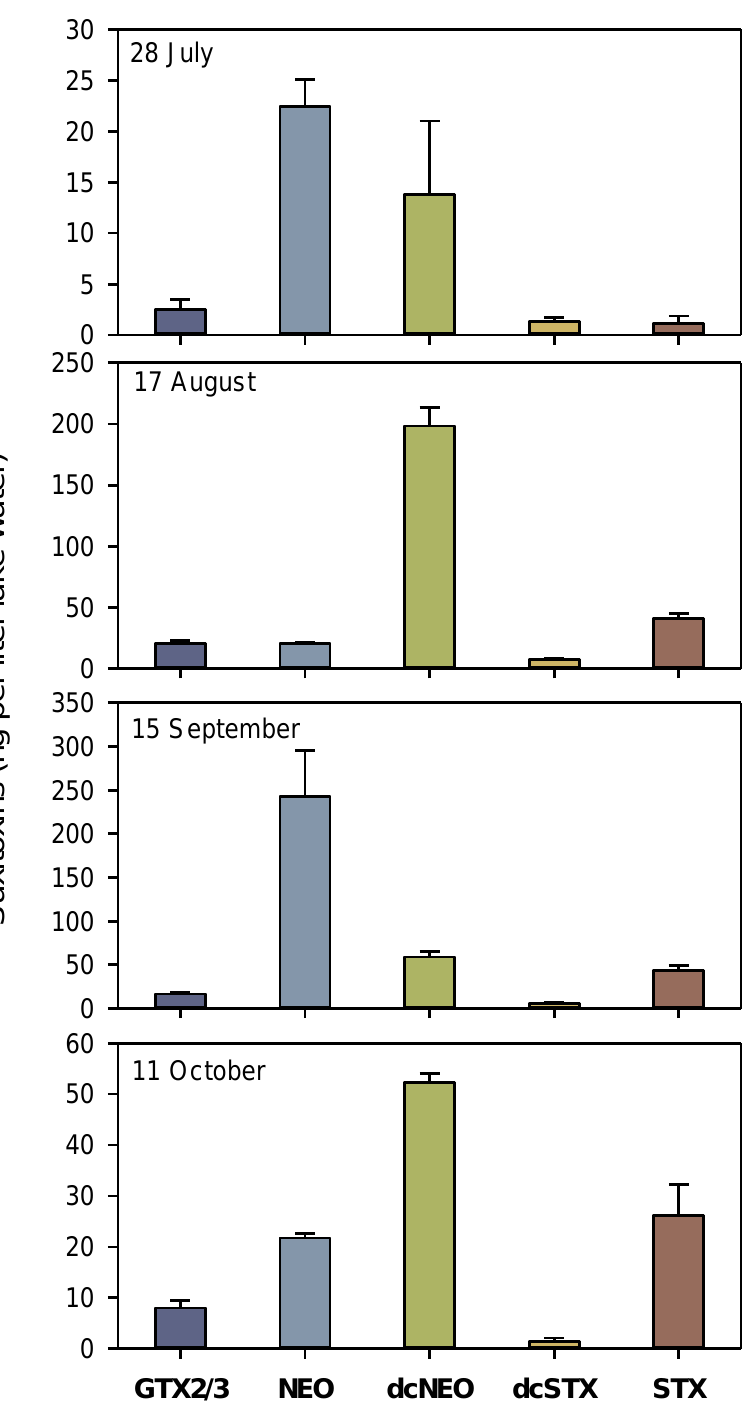
Figure 2. Concentrations of dissolved saxitoxin analogs in Lake Arresø in 2020, quantified by HPLC. Means ± 1 STD are shown ( n = 3).